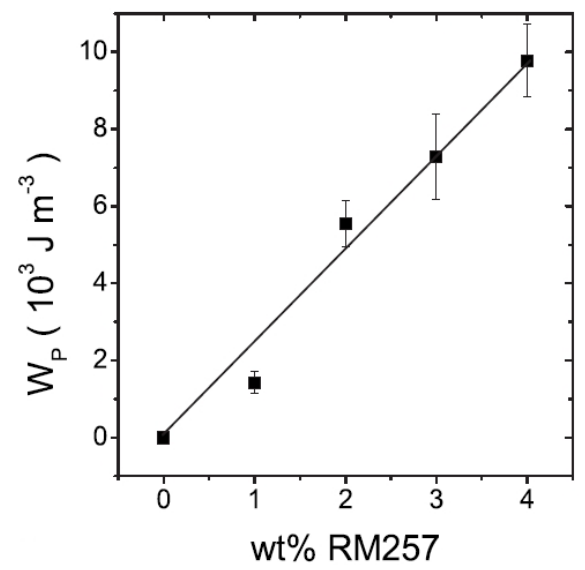
Figure 8. For small concentrations the elastic coupling coefficient between polymer network and liquid crystal increases linearly with increasing network density. (Reproduced with permission from [50]. Copyright 2008 American Physical